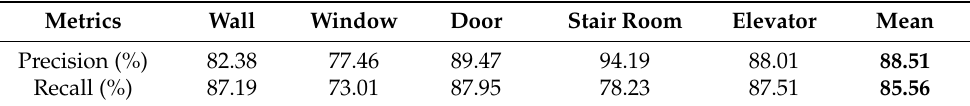
Table 2. Deep learning result.